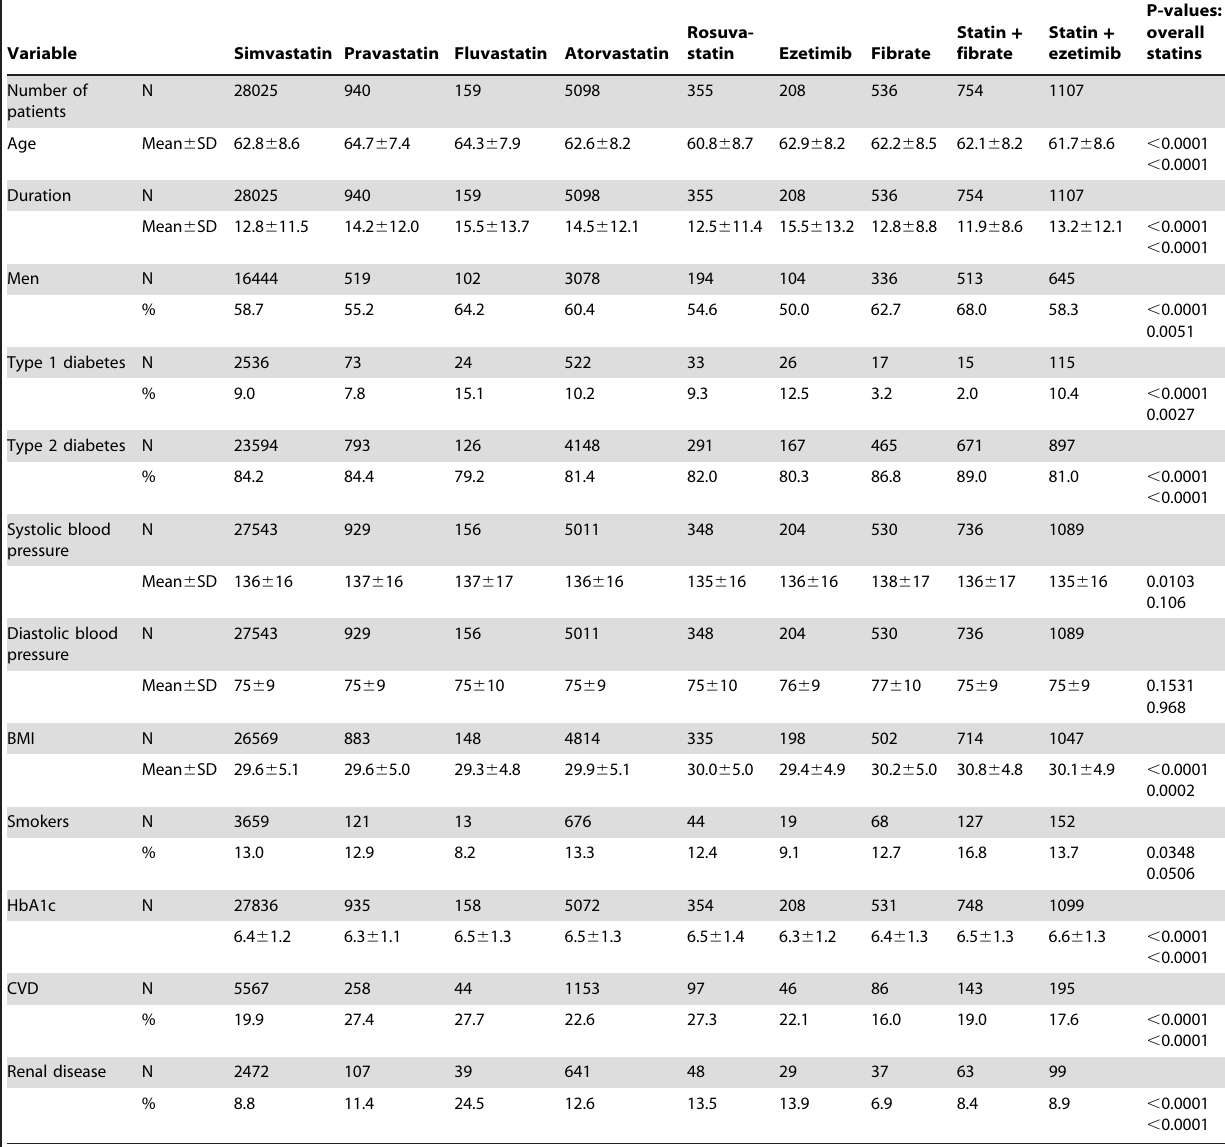
CVD, history of cardiovascular disease; Renal disease, history of renal disease. SD, standard deviation.